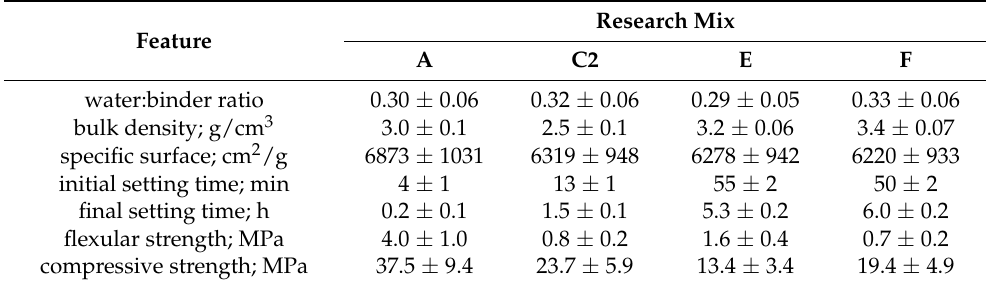
Table 4. Main properties of the obtained binders.